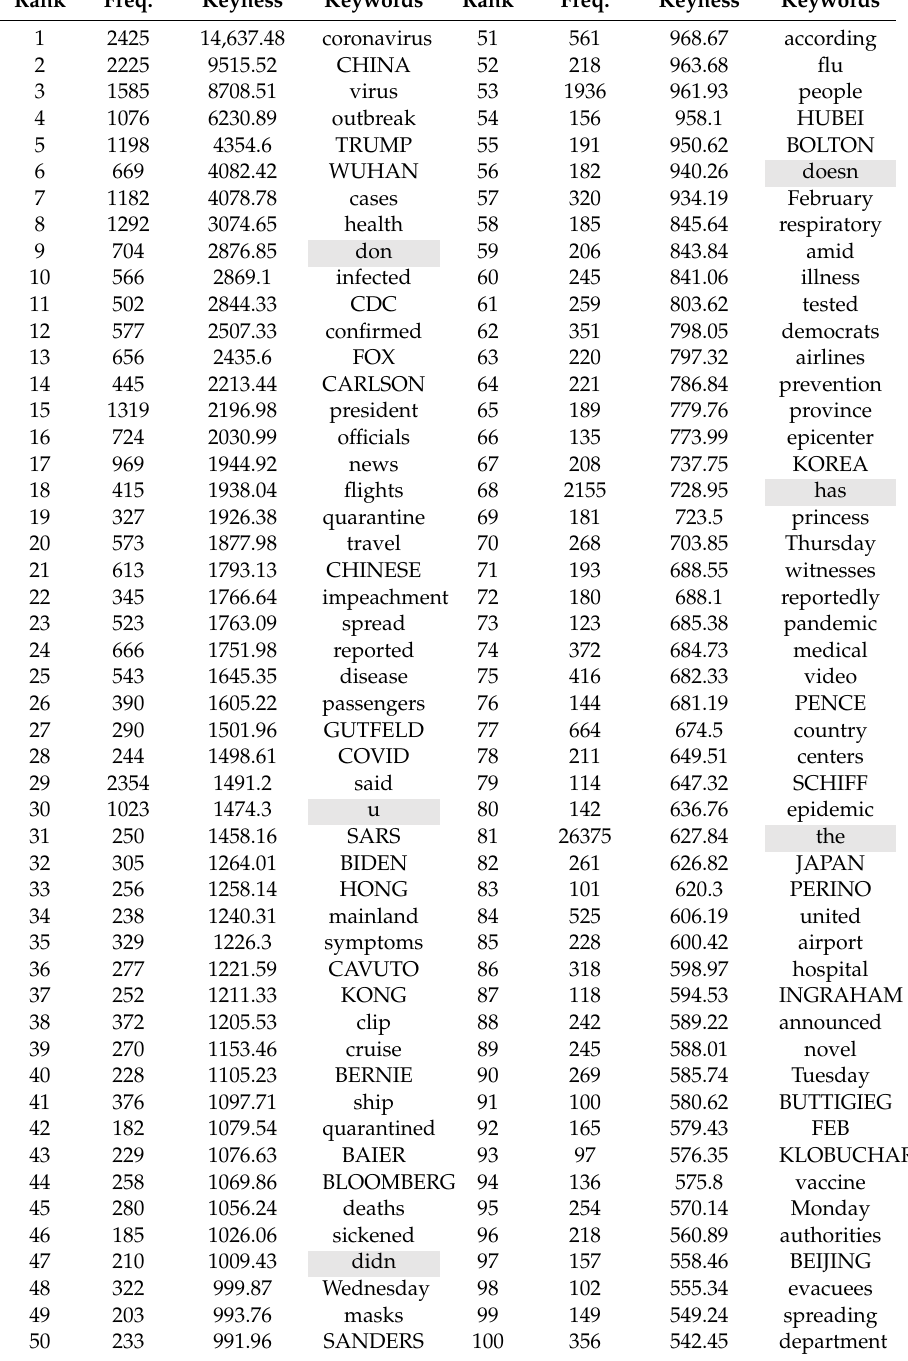
Table 3. An example of the keyword list from the input corpora (partial